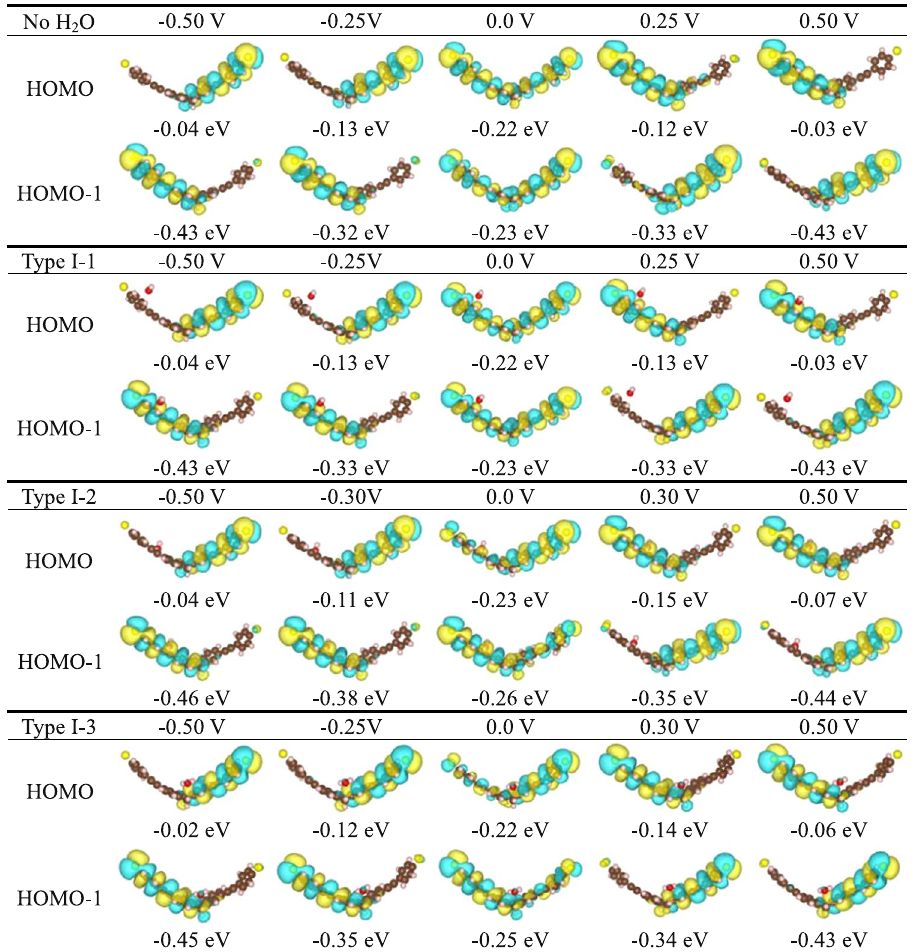
Figure 4. Spatial distributions of molecular orbitals for TADHA molecular junctions with one or without H 2 O adsorbate at 0.0 V, ± 0.5 V and at the voltage of peak-current values, where the orbital energies relative to the Fermi level are also shown under each